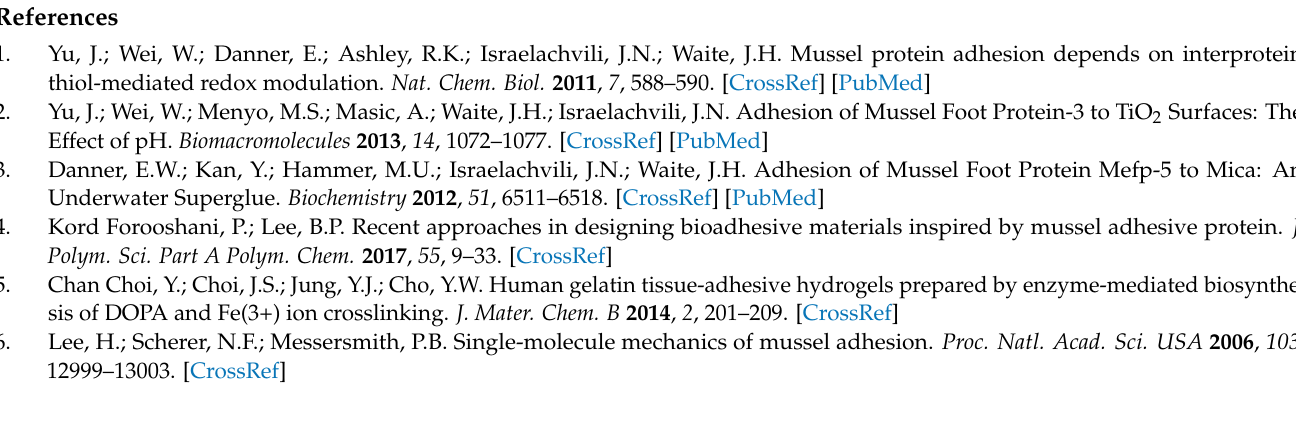
Figure S3: EDS mapping results of dried PEA-dhba-Fe 3+ bulk. Figure S4: Shear strength plotted to displacement of PEA-dhba-Fe 3+ bulk obtained from solutions with various pH values, the substrate utilized was aluminum. Figure S5: (a) Shear strength plotted to displacement of PEA-dhba upon various drying temperature for 15 min and (b) corresponding shear strength comparison. Figure S6: (a) Shear strength plotted to displacement of PEA-dhba upon various drying temperature for 8 h and (b) corresponding shear strength comparison. Table S1: Characteristic peak assignments of PEA-dhba-Fe 3+ . Table S2: Theoretical bare phenolic groups corresponding to mono-, bis-, and tris- complexation modes at various molar feed ratio of Fe 3+ :